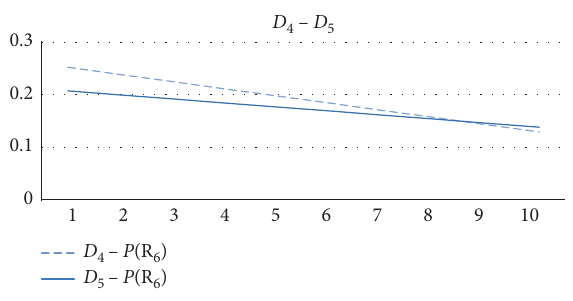
Figure 11: Sensitivity analysis of D